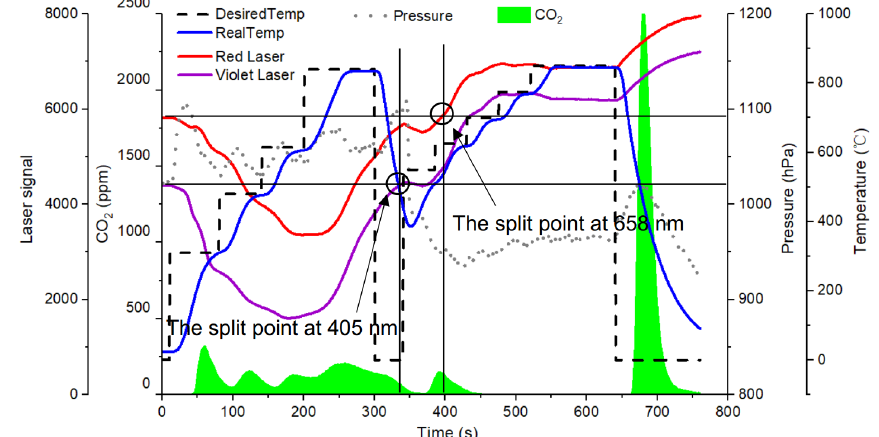
Figure 2. Example thermogram of sample analysis using the two-wavelength Sunset semi-continuous carbon